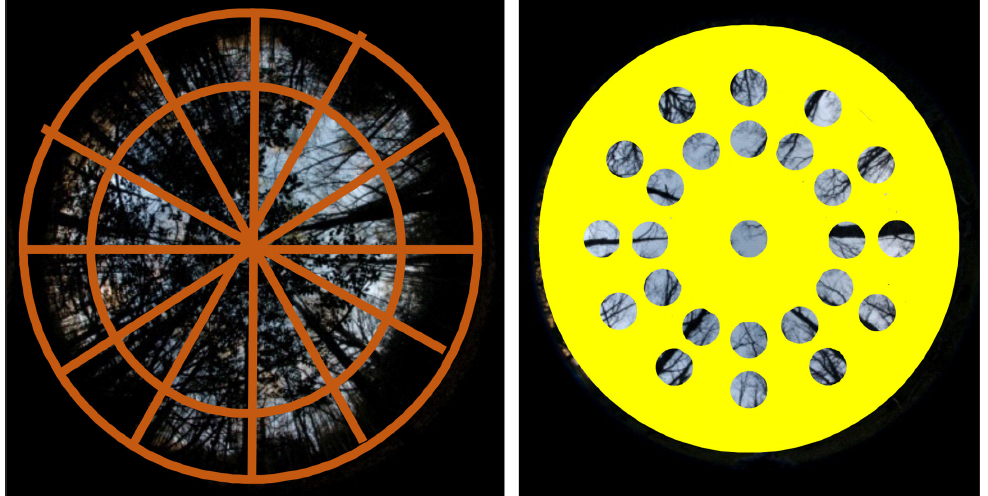
Figure 2 Development of the design of the canopy observation disk shows ( left ) 24 transparent sectors in the canopy projection, and ( right ) an arrangement of 25 holes of 10-mm diameter cut through a solid wooden panel with a